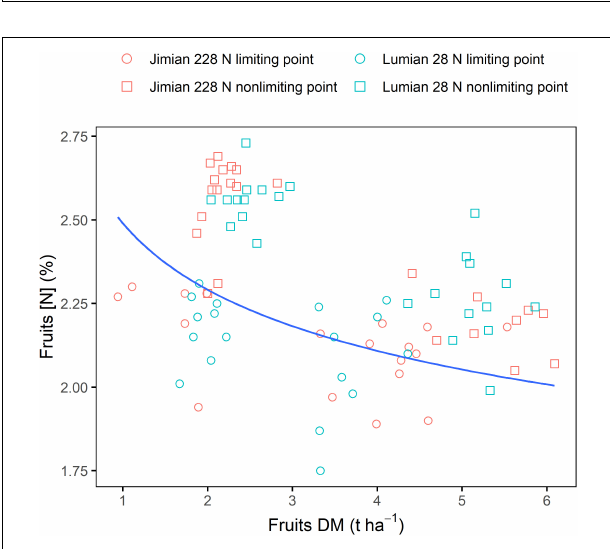
FIGURE 4 | Validation of critical fruits dilution curve using independent datasets from two cotton cultivars in the 2020 cropping season. DM, dry mass; and [N], N concentration. Points shown for the values of the three replicate plots at each sampling date. The data for fruits DM and [N] in 2020 are shown in Supplementary Table 4 .